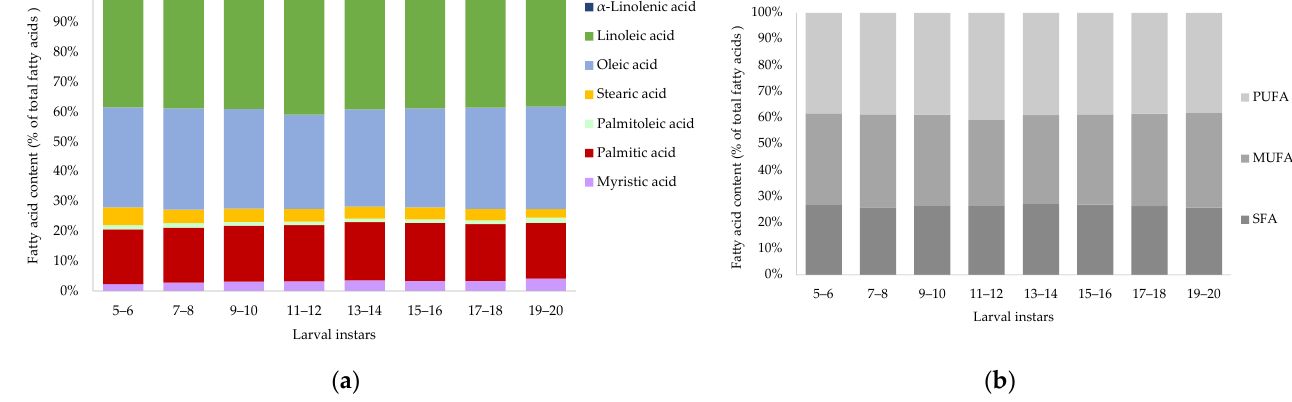
Figure 5. ( a ) Fatty acid content (relative % of total fatty acids) and ( b ) saturated (SFA), monounsaturated (MUFA) and polyunsaturated (PUFA) fatty acids (relative % of total fatty acids) of Tenebrio molitor larvae of different larval instars (5 to 20) on a dry matter (DM) basis analyzed by GC-FID. Data are presented as mean, n = 4.